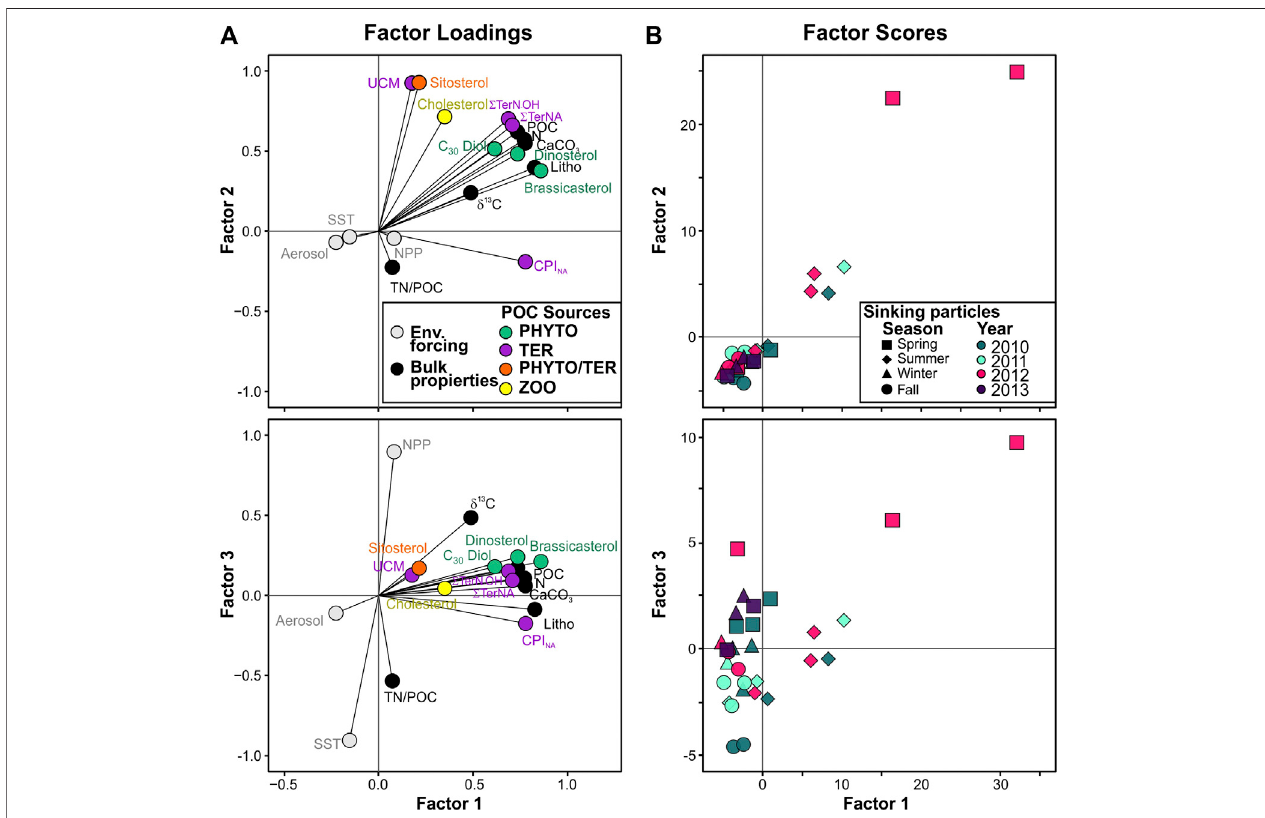
FIGURE 9 | PCA results. (A) Factor loadings for environmental forcing, bulk properties, and biomarkers of phytoplankton-derived POC (Phyto, green), zooplankton-derived POC (Zoo, yellow), and land-derived natural and anthropogenic POC (TER, purple) for the collected sinking particles. (B) Biplots of main factor scores for sinking particles identi fi ed by sampling year (colors) and season: fall (circle: September, October, November), spring (square: March, April, May), summer (diamond, June, July, August) and winter (triangle: December, January, February).